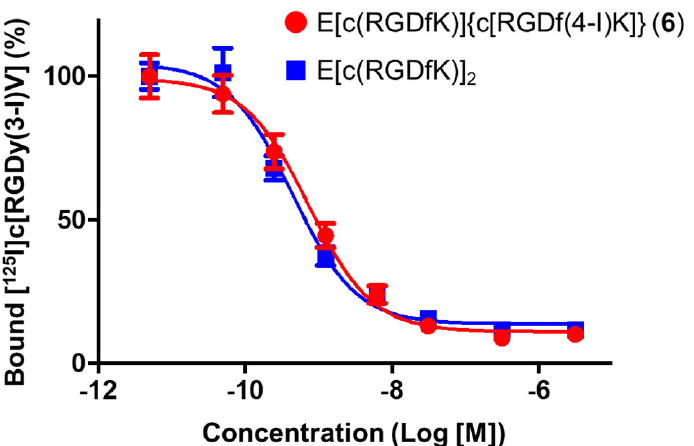
Figure 2. α v β 3 Integrin binding assay. Representative displacement curves of the competitive binding of [ 125 I]c[RGDy(3-I)V] to α v β 3 integrin on U-87 MG cells with E[c(RGDfK)] 2 and 6 . Error bars represent SD.